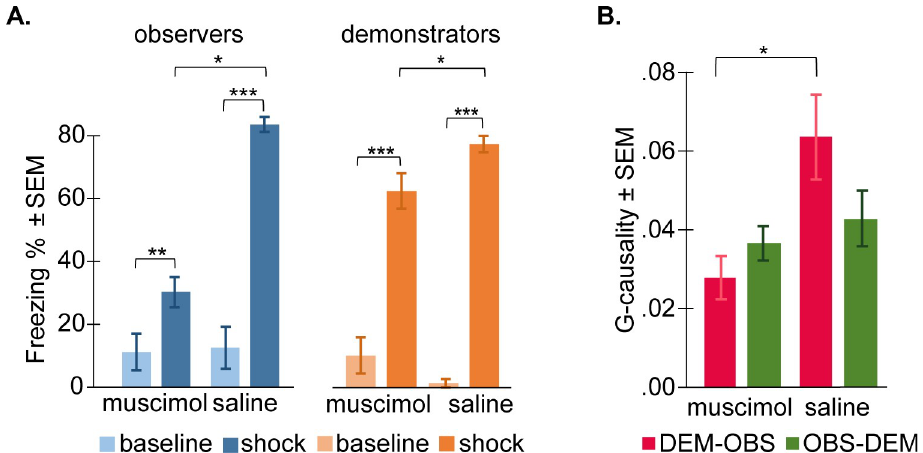
Fig 9. The role of ACC. (A) Effect of ACC deactivation on freezing. Percentage of time the observers (in orange) and demonstrators (in blue) spent freezing during baseline (light color) and the shock period (dark color) after ACC deactivation (muscimol) or after control treatment (saline). Freezing percent = 100 � freezing time/total time of the corresponding period. (B) Effect of ACC deactivation on the flow of information. Mean ± SEM of the G-causality values in the demonstrator-to-observer direction (DEM–OBS, in red) and in the observer-to-demonstrator direction (OBS–DEM, in green) during the shock period, after ACC deactivation (muscimol), or after control treatment (saline). Data can be found at http://dx.doi.org/10.17632/h8fkyr2z35.1. ACC, anterior cingulate cortex; DEM, demonstrator rat; G-causality, Granger causality; OBS, observer rat; SEM, standard error of the mean.